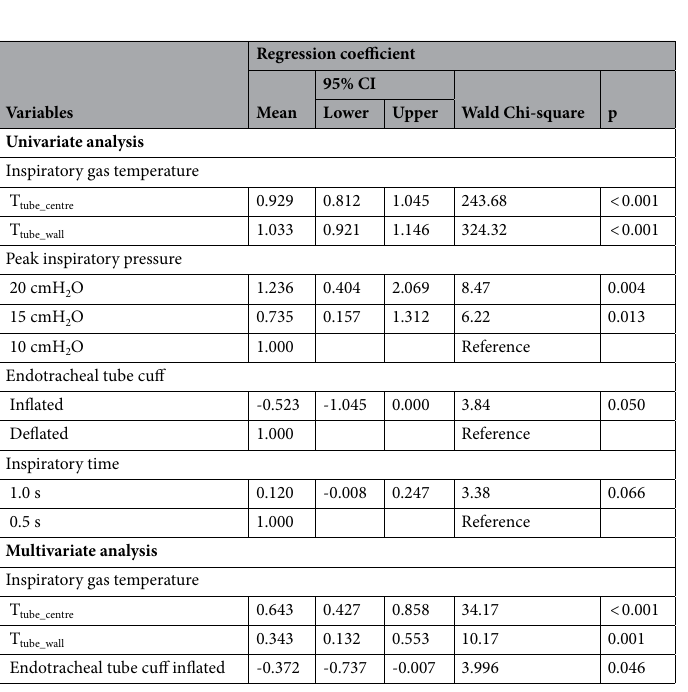
Table 1. Dependence of T airway on other inspiratory gas temperatures and covariates: univariate and multivariate analyses.